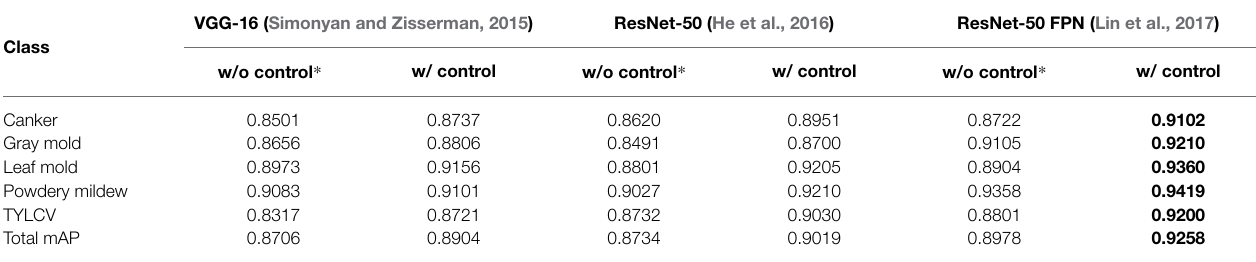
TABLE 3 | Experimental results of training/validating the model on the baseline dataset with and without using control classes. VGG-16 (Simonyan and Zisserman, 2015) Class